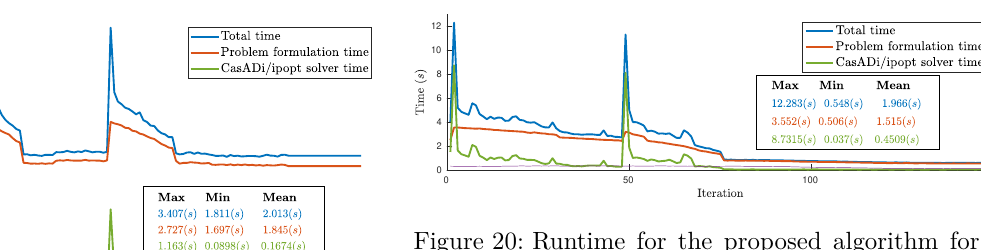
Figure 20: Runtime for the proposed algorithm for a very confined space simulation with 4 TSs that require avoidance